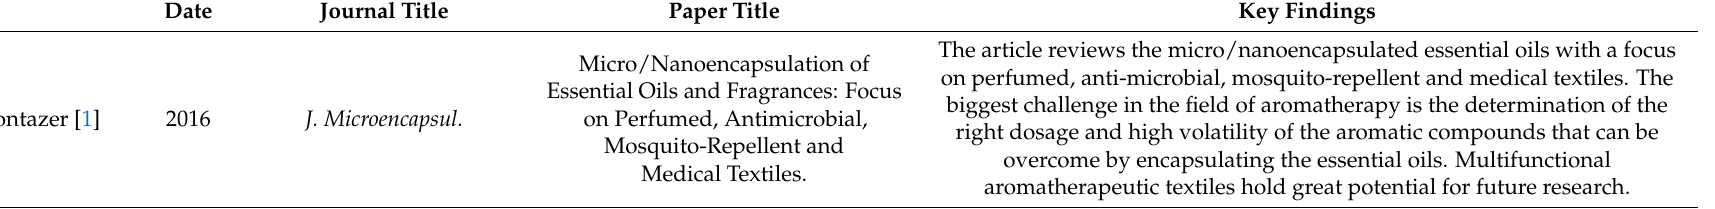
Table 1. Summaries of the aromatherapy studies reviewed for this